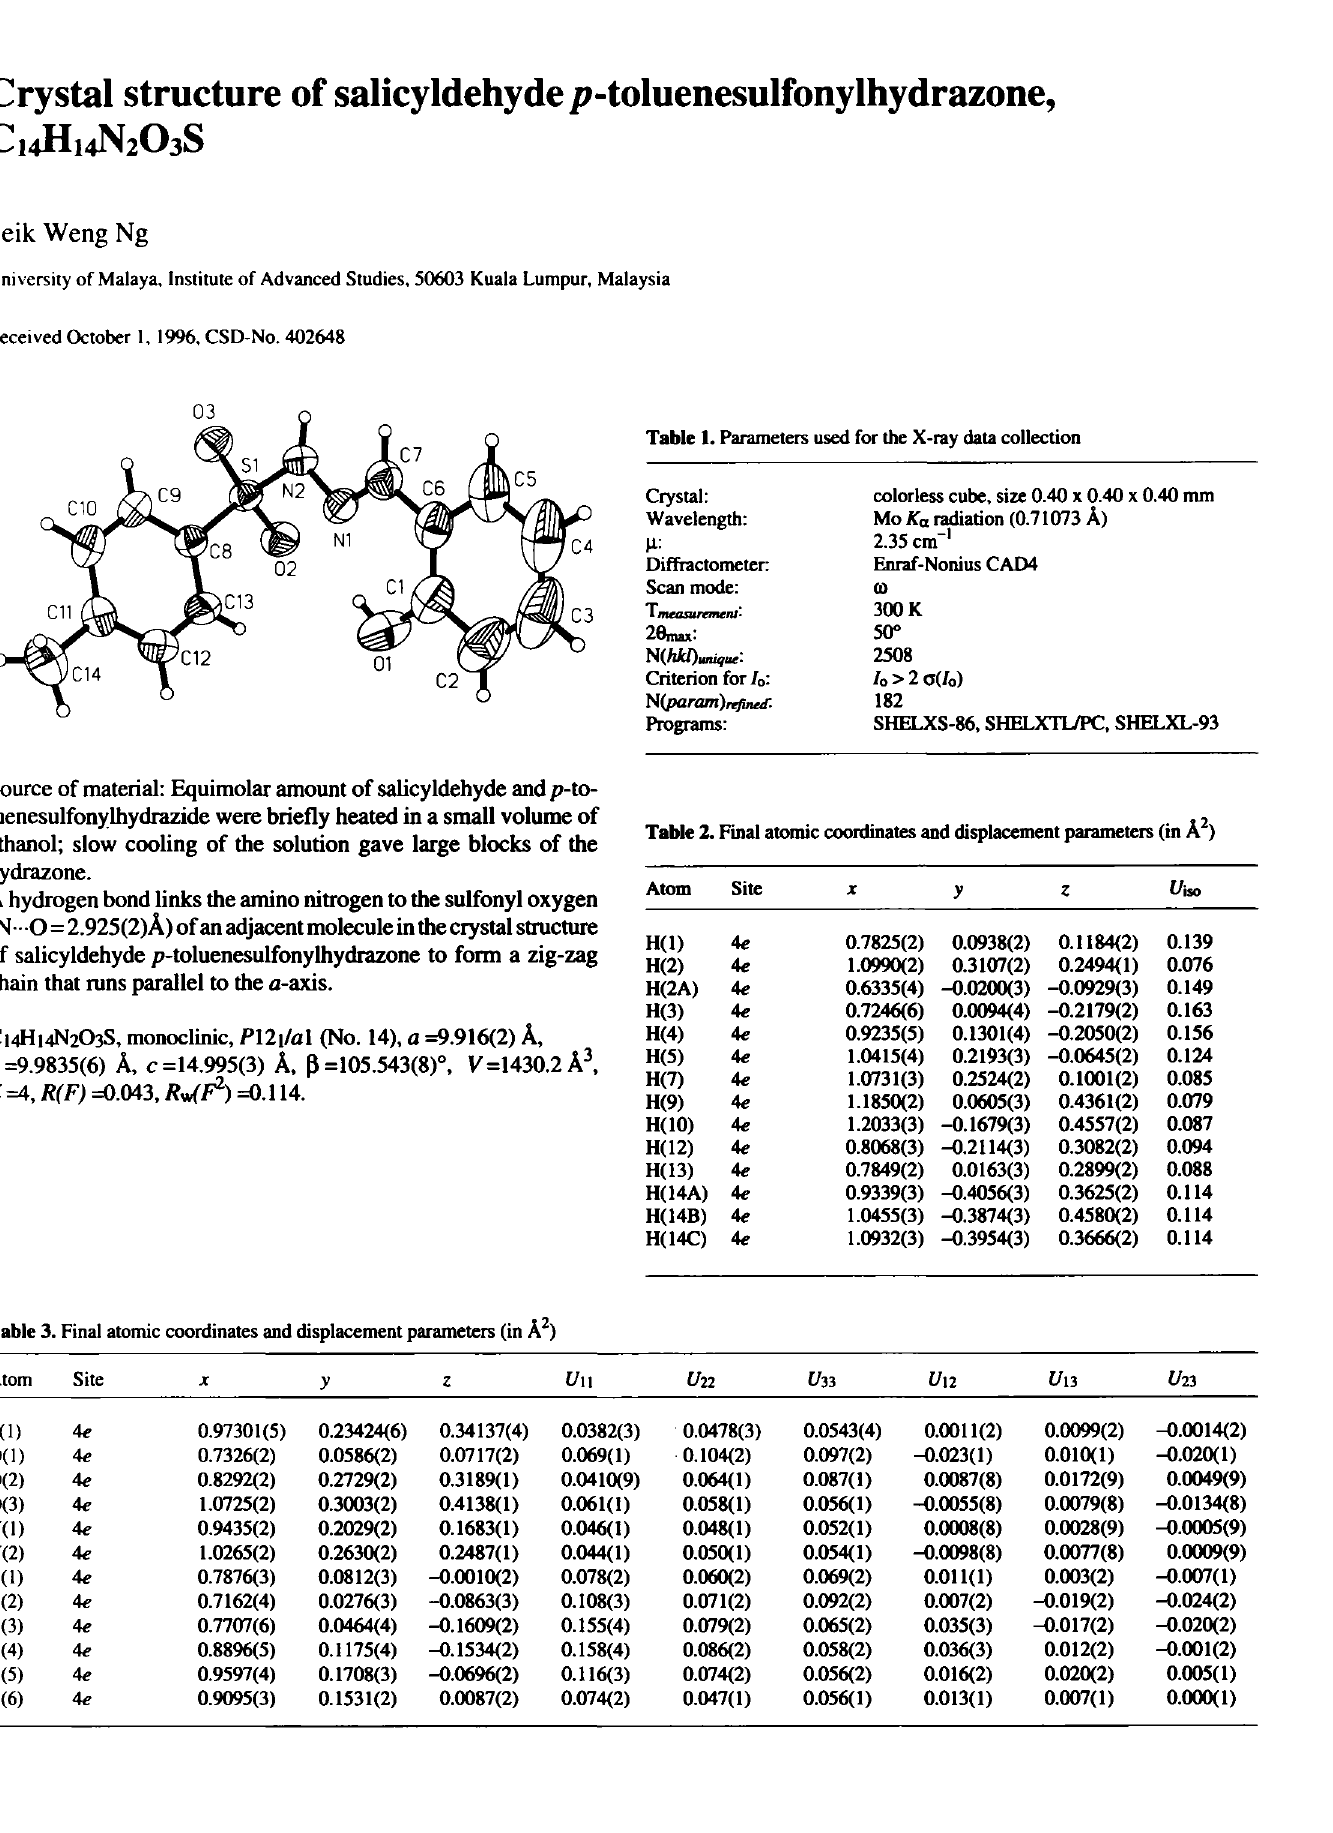
Table 1. Parameters used for the X-ray data collection Crystal: